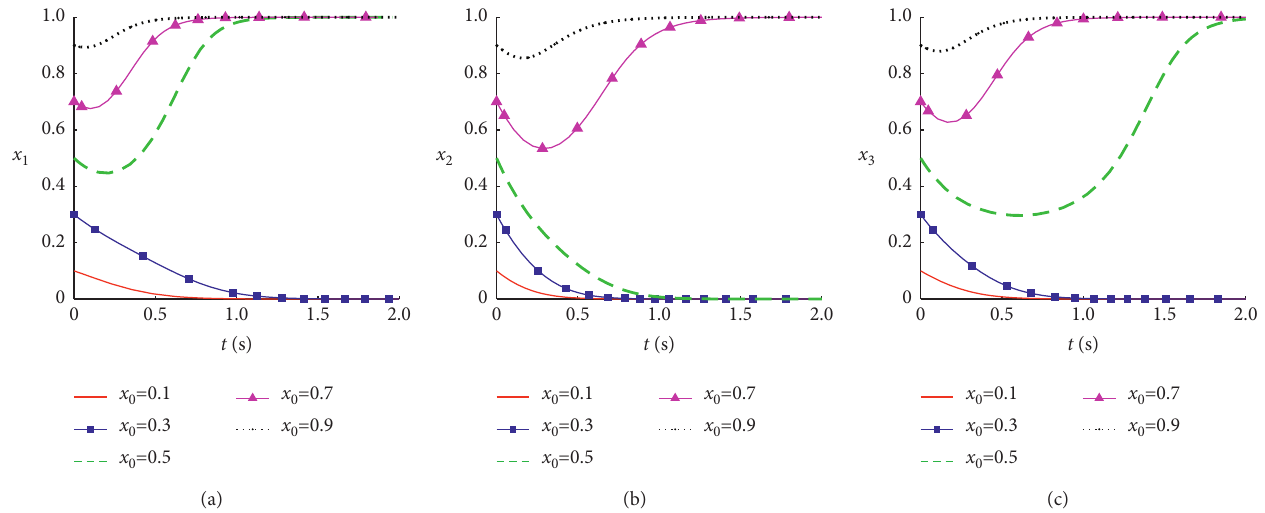
Figure 4: Evolutionary paths of the proportion of lane changing strategy under different initial proportions. (a) Model 1; (b) Model 2; (c) Model 3.